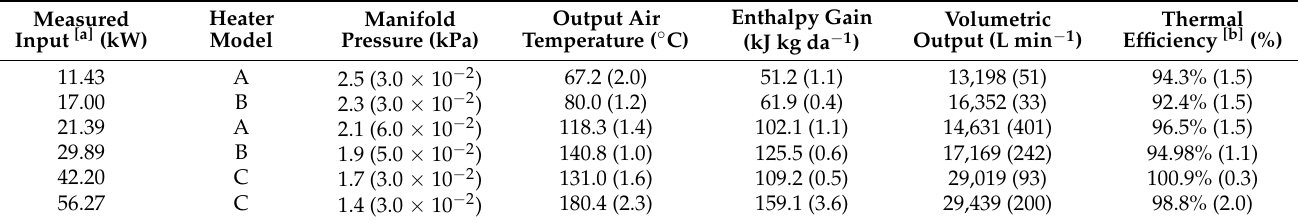
Table 11. Average (standard deviation) of test conditions and measured performance values for all three DGFCH models and